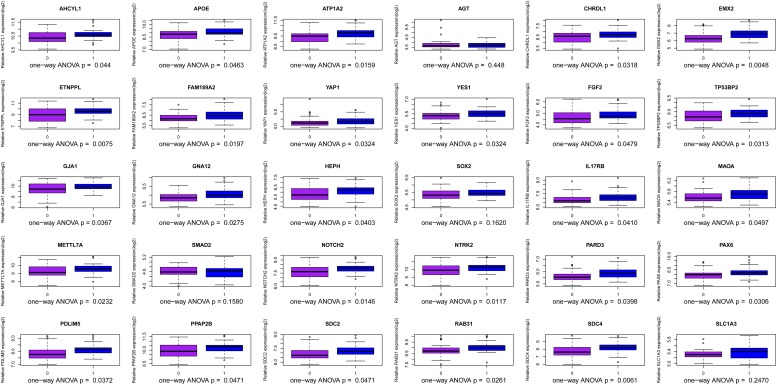
Boxplot for identification of hub genes in the three modules.